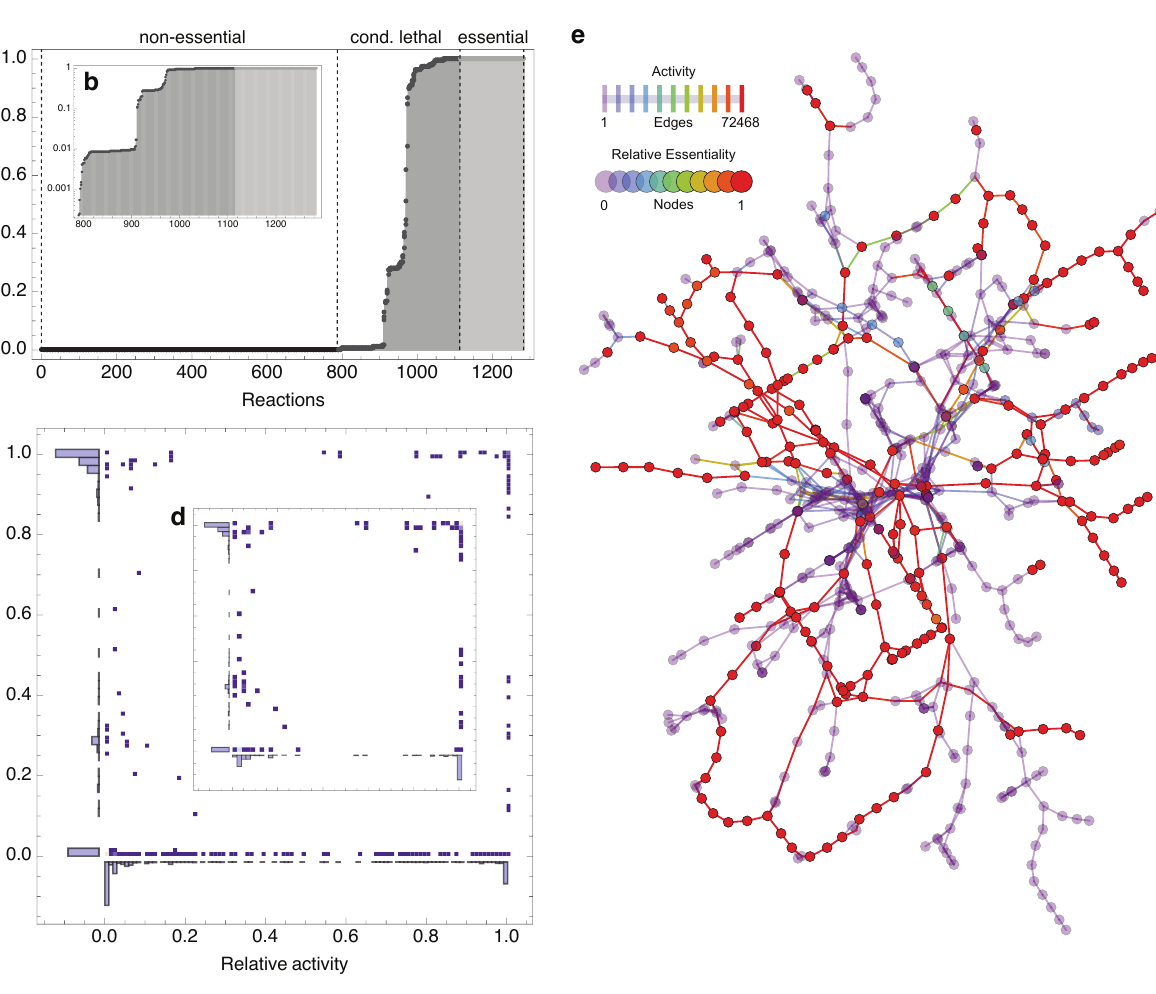
Figure 2. Outcome of combinatorial minimal media simulations. ( a ) Sorted relative essentiality profile determined by the simulation of reaction deletions under 72468 combinatorial minimal media conditions. The three different essentiality classes are indicated by dashed lines. Inset ( b ) shows the same profile using semilog plot. ( c ) No relation is observed between essentiality and activity ( non-essential reactions have been removed in inset ( d ); relative activity is the number of simulations that a reaction was active normalized by the total number of simulations). ( e ) A reaction-centric network diagram illustrating the relative essentiality on the nodes (707 reactions) and co-occurring activity on the edges of the cytoplasmic part of the i AF1260 model (transport, periplasmic, and blocked reactions have been discarded; currency metabolite have been removed manually, see